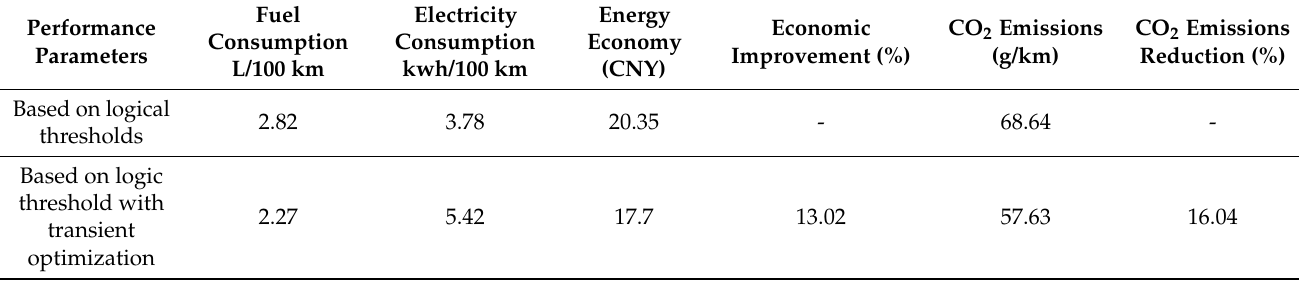
Table 4. Comparison of economic performance on the test road.